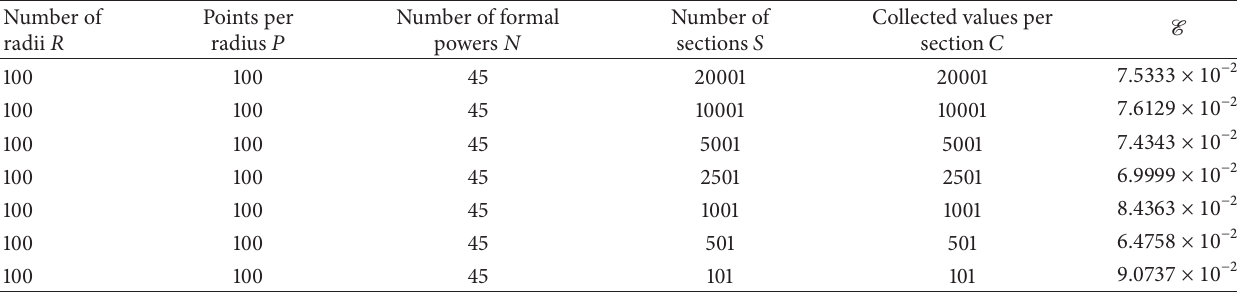
Table 13: Relation between the error E and the number of sections 𝑆 and samples per section 𝐶 , when 𝜎 = 2 + sin (𝑥 + 𝑦) . Number